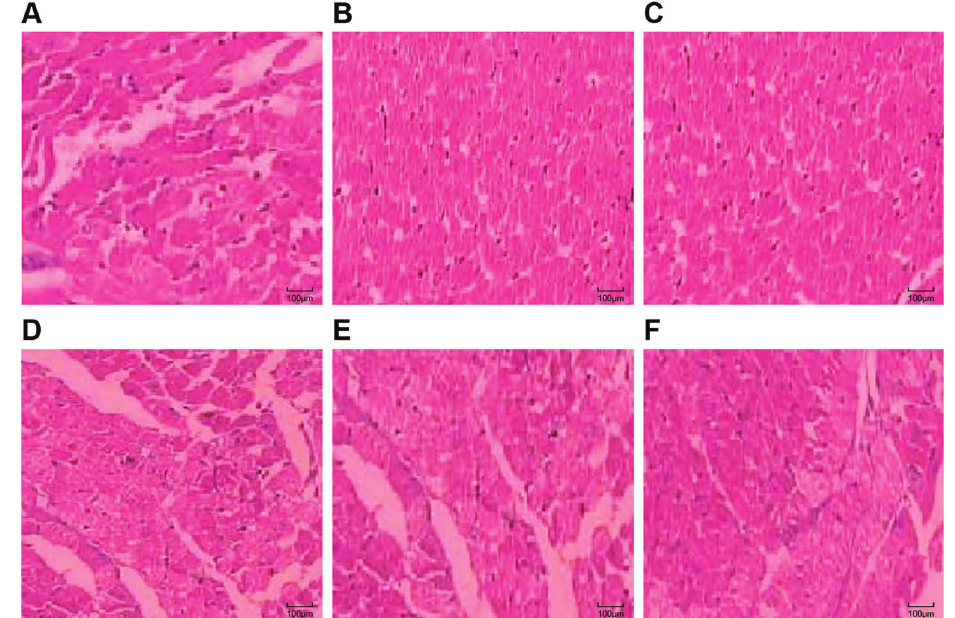
Figure 2. Hematoxylin-eosin staining of myocardial tissue in the sham operation (S) group ( A ), ischemia-reperfusion (I/R) group ( B ), normal saline (NS) group ( C ), fentanyl (Fen)1 group (2 m g/kg) ( D ), Fen2 group (4 m g/kg) ( E ), and Fen3 group (6 m g/kg) ( F ).